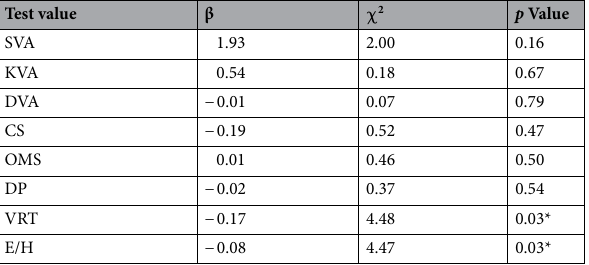
Table 3. Tests of significant differences in sports vision tests in the eight-test model. Notes: Model including all eight tests. Abbreviations: SVA: static visual acuity, KVA: kinetic visual acuity, DVA: dynamic visual acuity, CS: contrast sensitivity, OMS: ocular motor skill, DP: depth perception, VRT: visual reaction time, E/H: eye hand coordination.